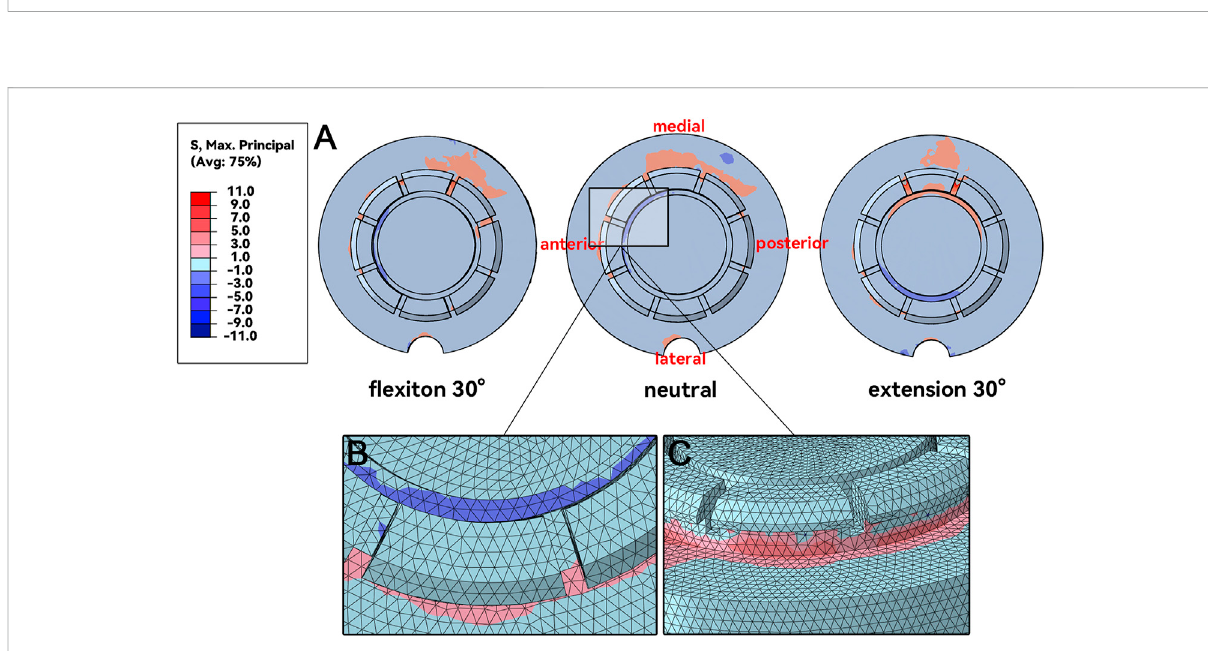
FIGURE 6 MPS at fi xation claws. (A) , maximum principal stresses distribution. (B&C) , details of the inner side and outer side of the connection